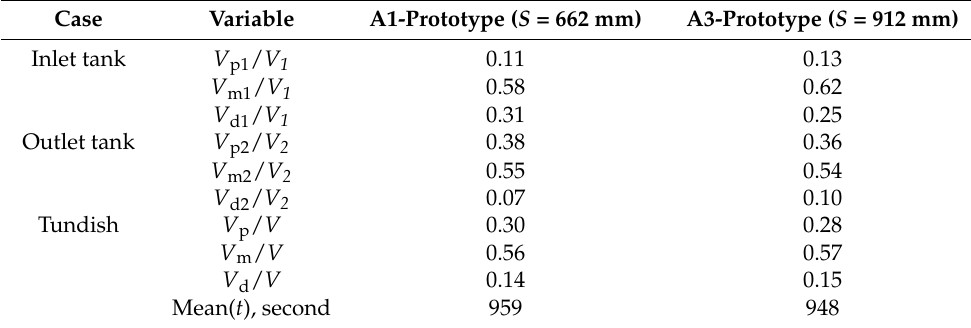
Table 9. Data analysis of RTD curves in real tundish (CFD